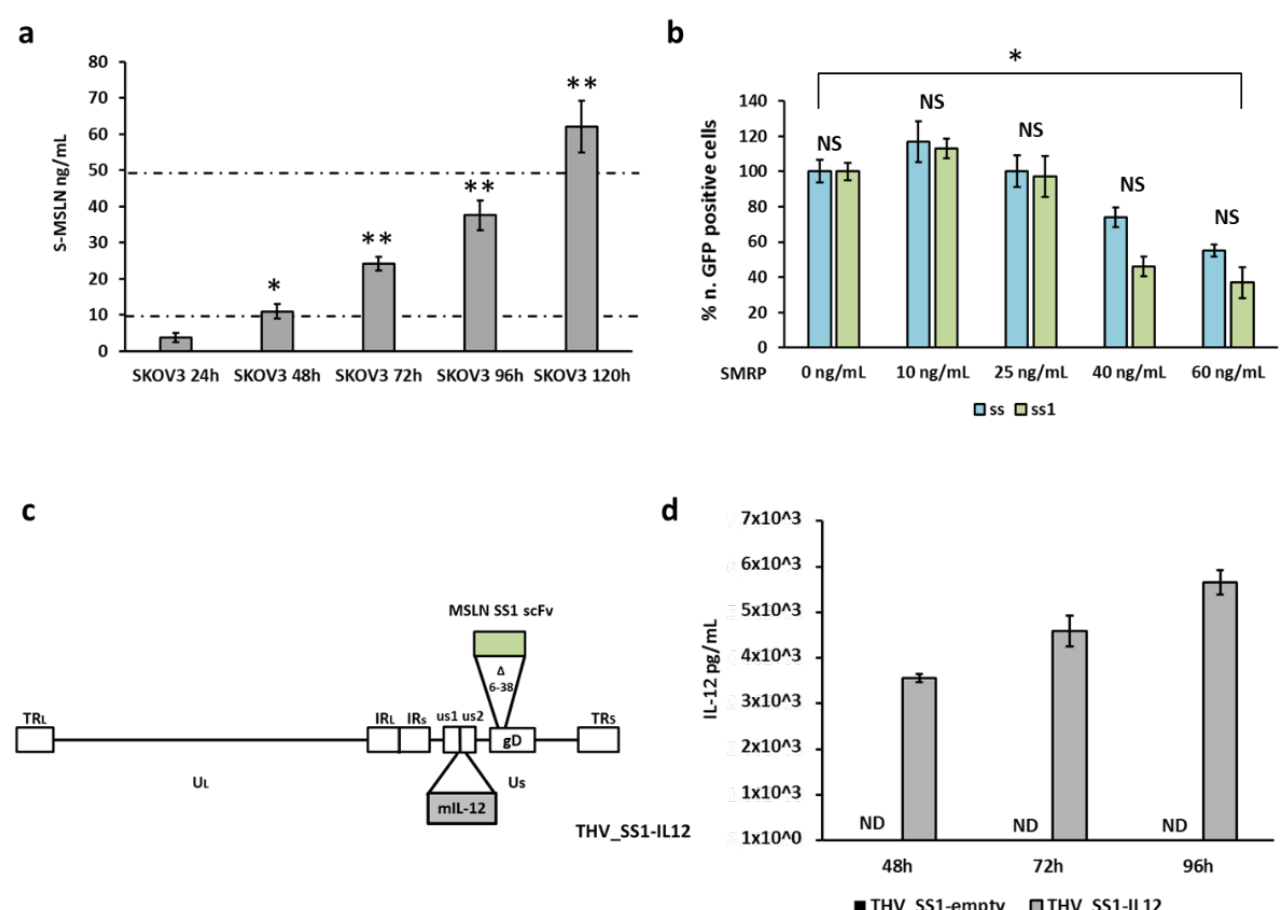
Figure 2. Soluble MSLN does not interfere with virus spread and mIL12 production. ( a ) Secreted soluble MSLN in supernatant of SKOV3 cell line was quantified by ELISA assay up to 120 h post seed. Dashed lines define the range of soluble mesothelin (SMRP) concentration in tumor patients. The statistical significance was calculated by Student’s t -test and resulted p < 0.05 * comparing 24 and 48 h, p < 0.005 ** comparing 48 and 72 h/72 and 96 h/96 and 120 h. ( b ) The same conditioned media described in panel A were used to infect fresh SKOV3 cells with THV_SS (light blue) and THV_SS1 (green) resulting in limited alteration of viral entry at the highest SMRP concentrations. The statistical significance was calculated by Student’s t -test and resulted not significant (NS) comparing THV_SS and THV_SS1 at each time point and p < 0.05 * comparing both THV_SS and THV_SS1 at 0 and 60 ng/mL. ( c ) Schematic cartoon of second generation THV_SS1 encoding mIL-12 (THV_SS1-IL12); the mIL-12 expression cassette was inserted into the intergenic region US1/US2. ( d ) Production of mIL-12 cytokine quantified by ELISA assay from 48 to 96 h.